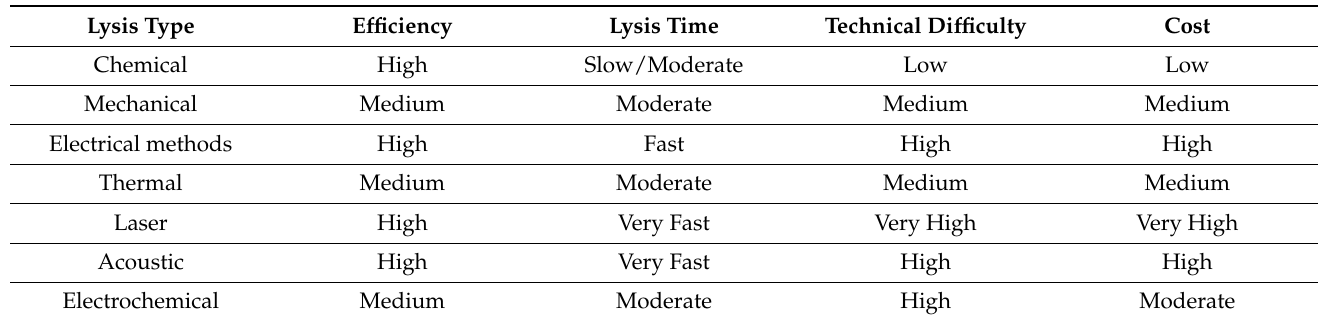
Table 1. Summarized comparison of the described